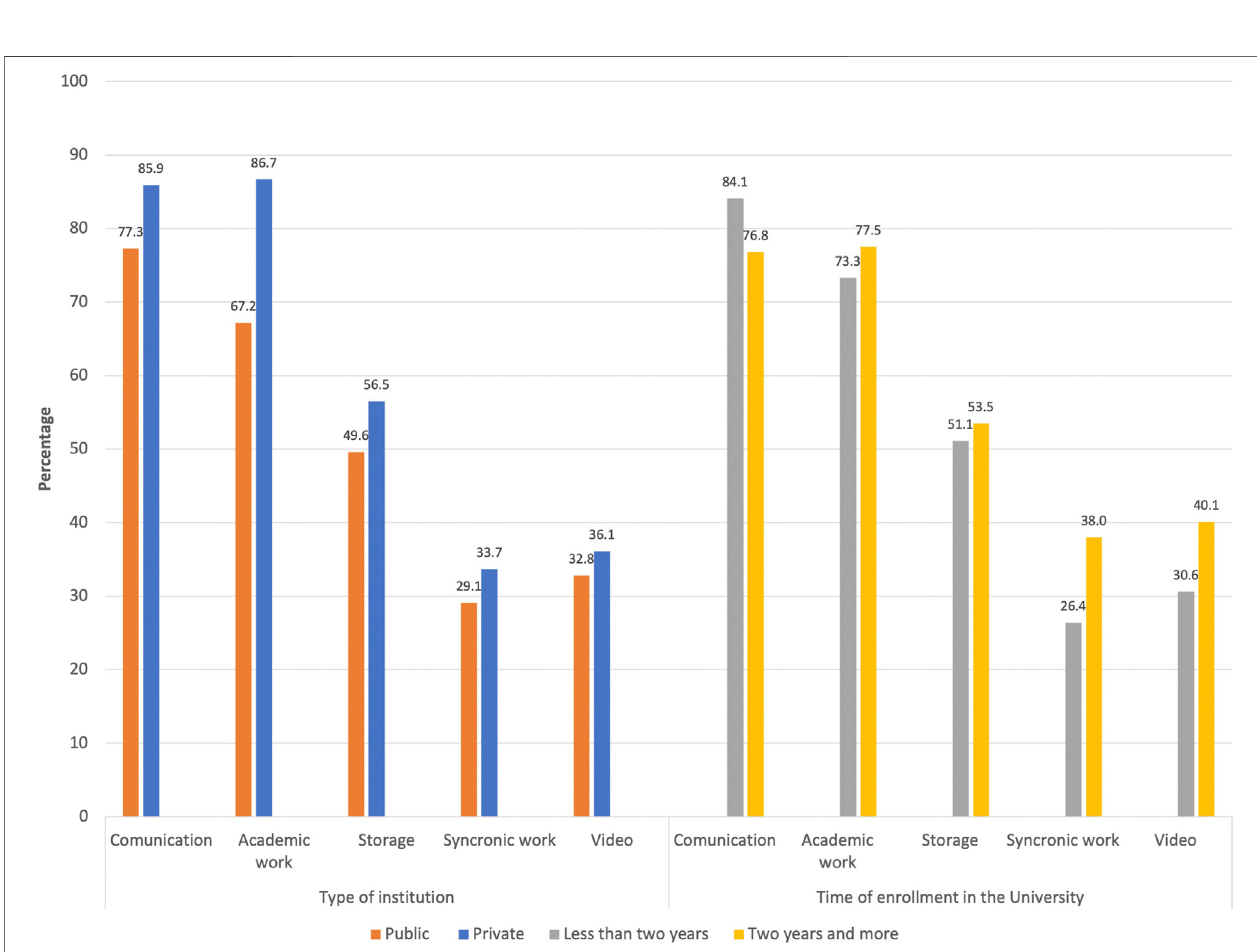
FIGURE 1 | Use of technological tools to support students ’ learning process before the emergency remote teaching model implementation, by type of institution and time of enrollment in the university.